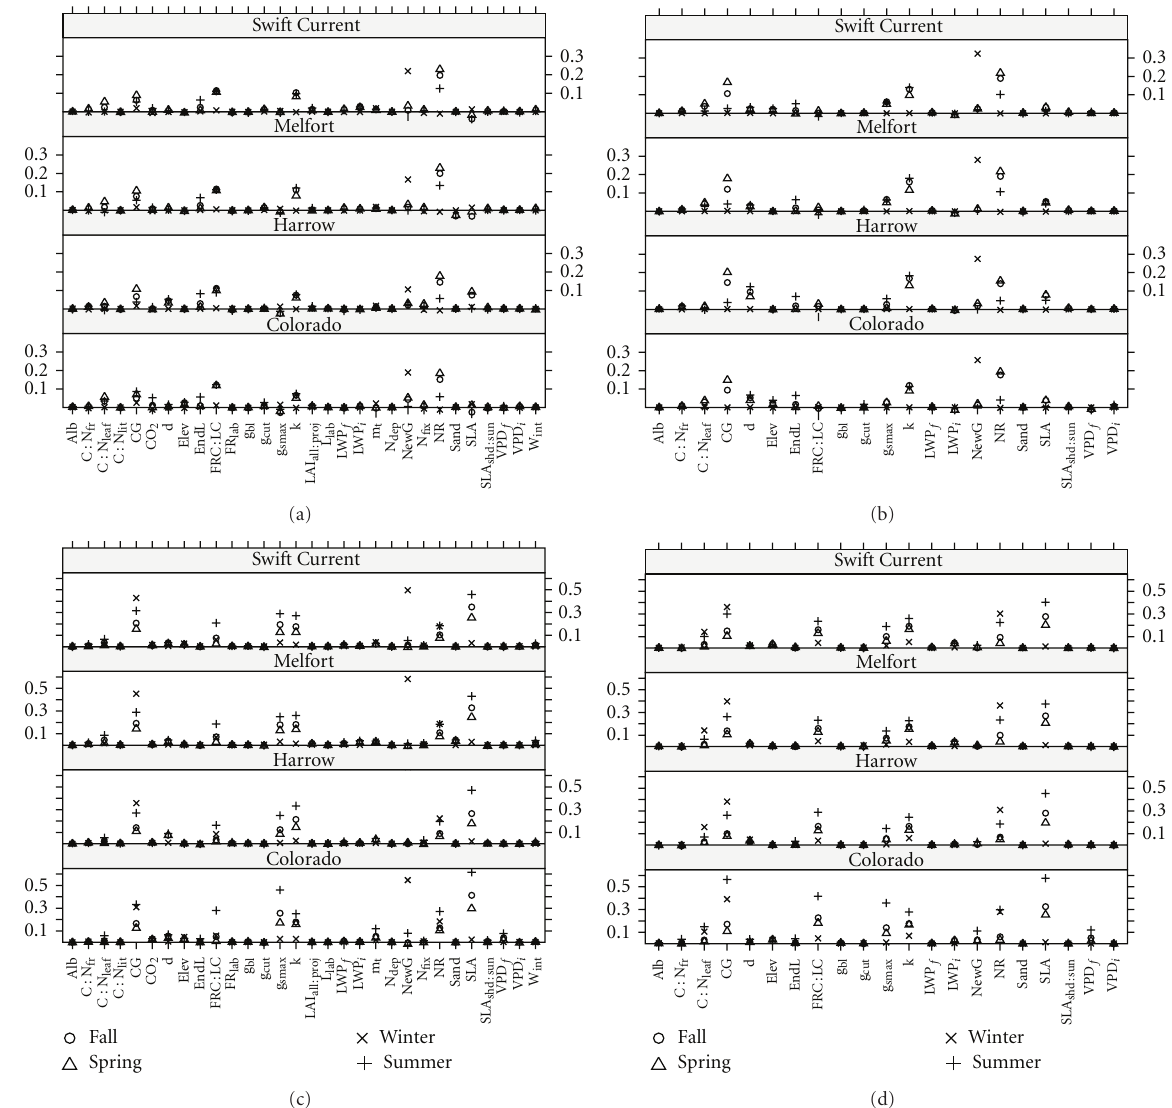
Figure 3: Sensitivity indices for NPP based on (a) main e ff ects using all inputs; (b) main e ff ects using a reduced set of inputs; (c) interaction e ff ects using all inputs; (d) interaction e ff ects using a reduced set of inputs. The total e ff ects (Sobol) index (TSI) is the addition of main e ff ects and interaction index (TSI for all set of model inputs is computed as the summation of index values shown separately within insets (a) (main e ff ects index) +(c) (interaction index), for a given parameter. Likewise, TSI for the reduced set of model inputs is the summation of indices shown within insets (b) (main e ff ects index) +(d) (interaction index), for a given parameter, and TSI significance/importance is classified/ranked according to: TSI > 0.8 (very important), 0.5 < TSI < 0.8 (important), 0.3 < TSI < 0.5 (unimportant), and TSI < 0.3